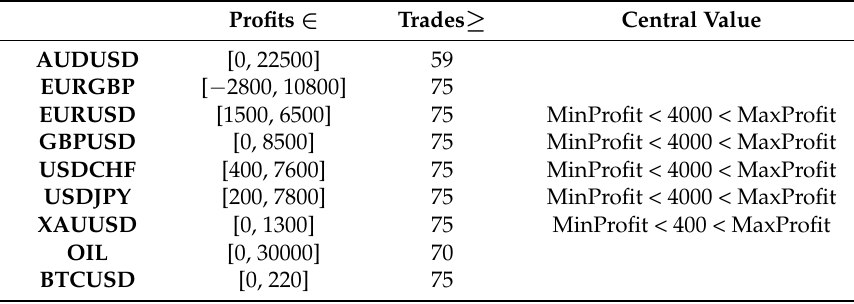
Table 1. Requirements set for neighborhood selection for each